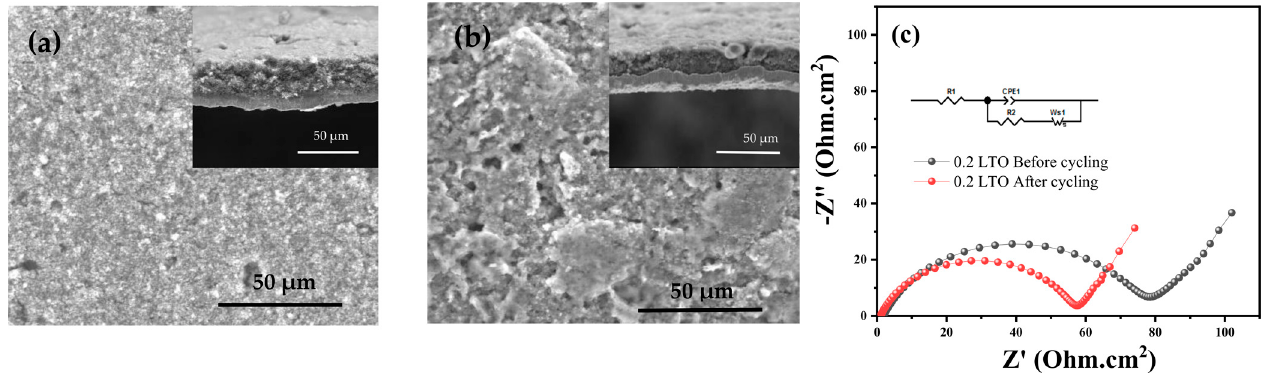
Figure 6. SEM images of iodide-doped LTO electrode: ( a ) before cycling with the insert of a cross- section of the electrode, ( b ) after cycling with the insert of cross-section of electrode, and ( c ) Nyquist plot with an inserted equivalent circuit.